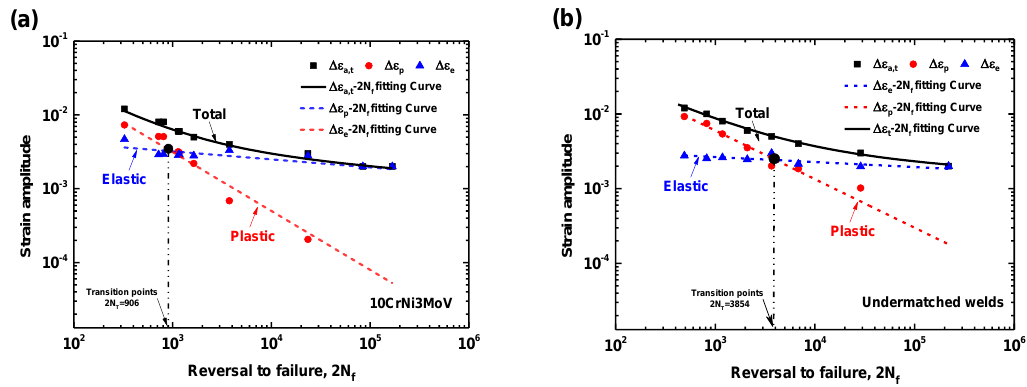
Figure 9. Manson-Coffin curves of test materials: ( a ) 10CrNi3MoV steel; ( b ) Undermatched welds.